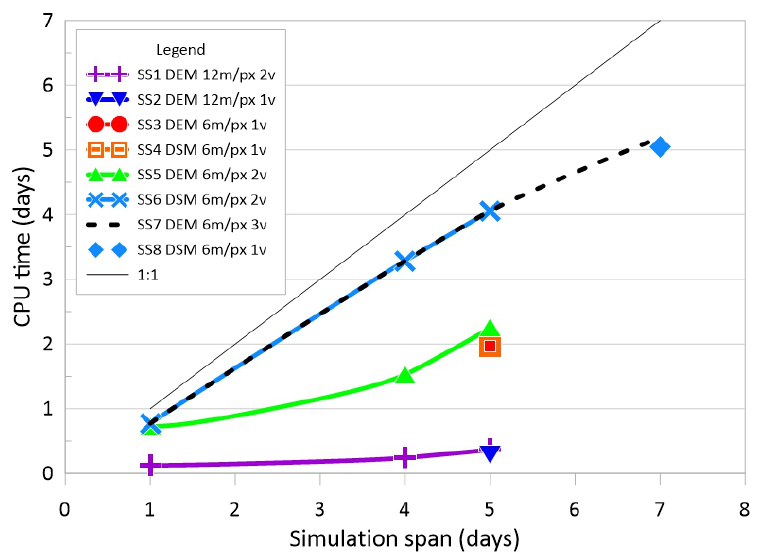
Figure 9. CPU time spent on the calculations of each of the simulations versus the evolution time of the simulated lava